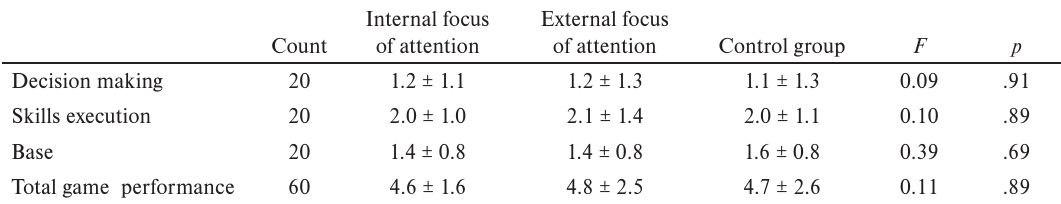
Performance scores (presented as M ± SD) for each group and the results of analysis of variance in pre-test